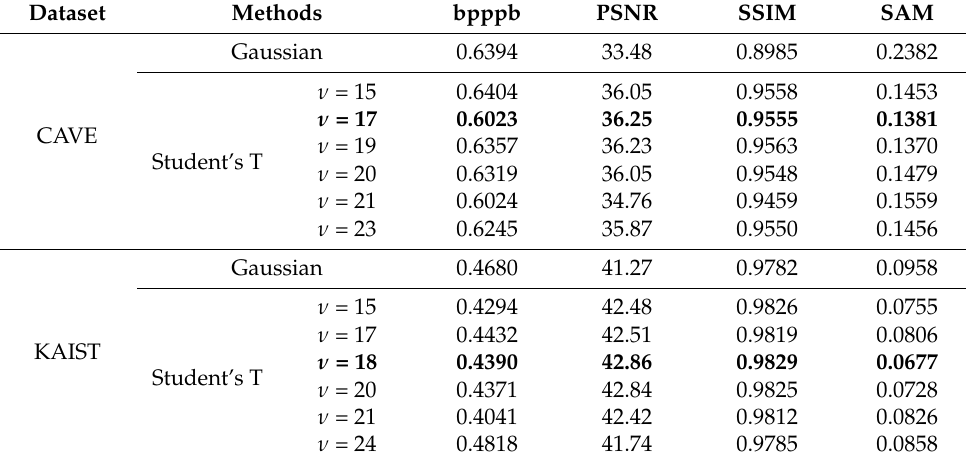
Table 1. Rate-distortion performance of various degrees of freedom for a particular bit rate. The comparatively ideal choice is marked in bold. Bpppb represents bit per pixel per